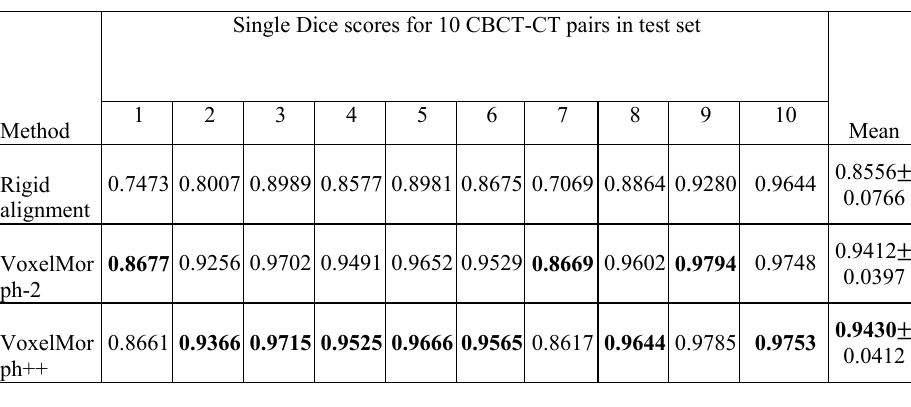
Table 1. Single and average Dice scores and runtime results for rigid alignment, VoxelMorph-2 and VoxelMorph++ (the proposed